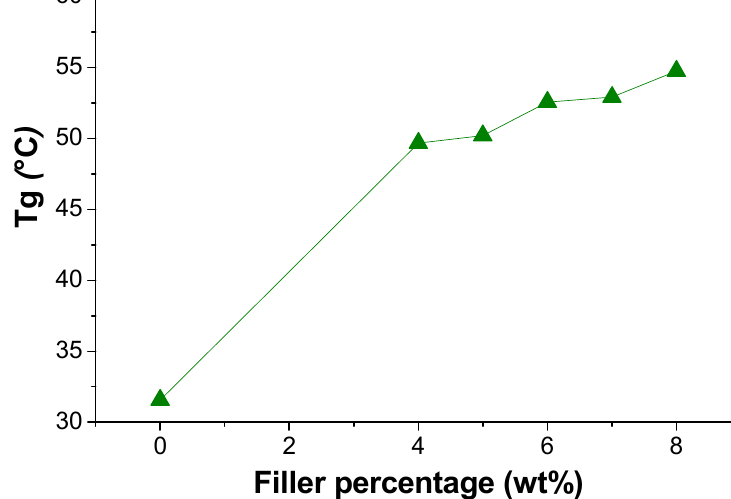
Figure 4. Glass transition temperature (differential scanning calorimetry (DSC)) of pristine PK30-Gly-Gly and of the respective composites containing lower degree of reduction graphene oxide (lrGO) as the filler.